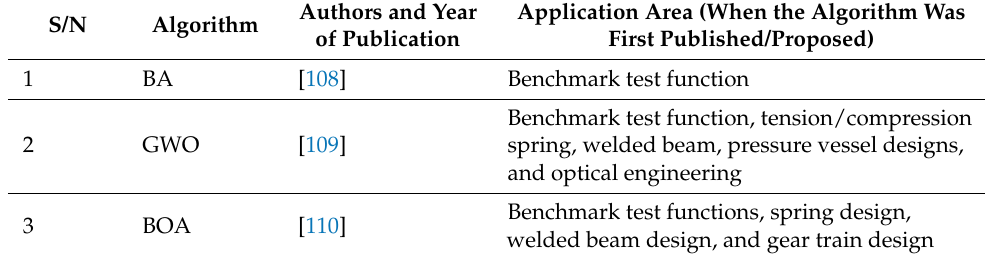
Table 9. Summary of algorithms